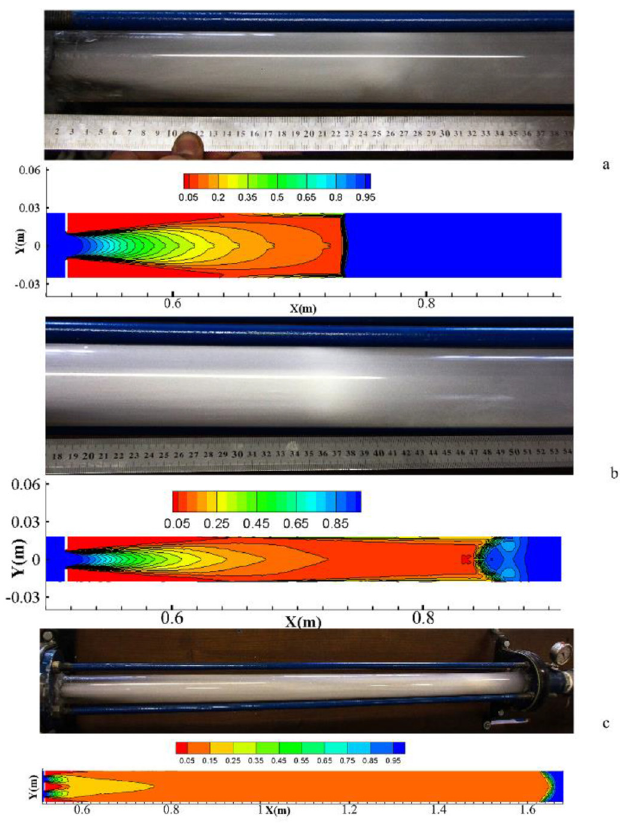
Fig. 22. The comparison of cavitation length in the fl ow of 26 m 3 /h resulted by the experimental and numerical tests in: (a) a single-hole ori fi ce with a two-sided sloped edge (b) a single-hole ori fi ce with a one-sided sloped edge and (c) a multi-hole ori fi